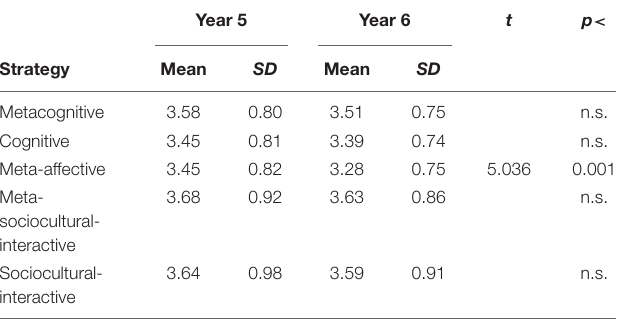
TABLE 6 | The strategy use results for the two